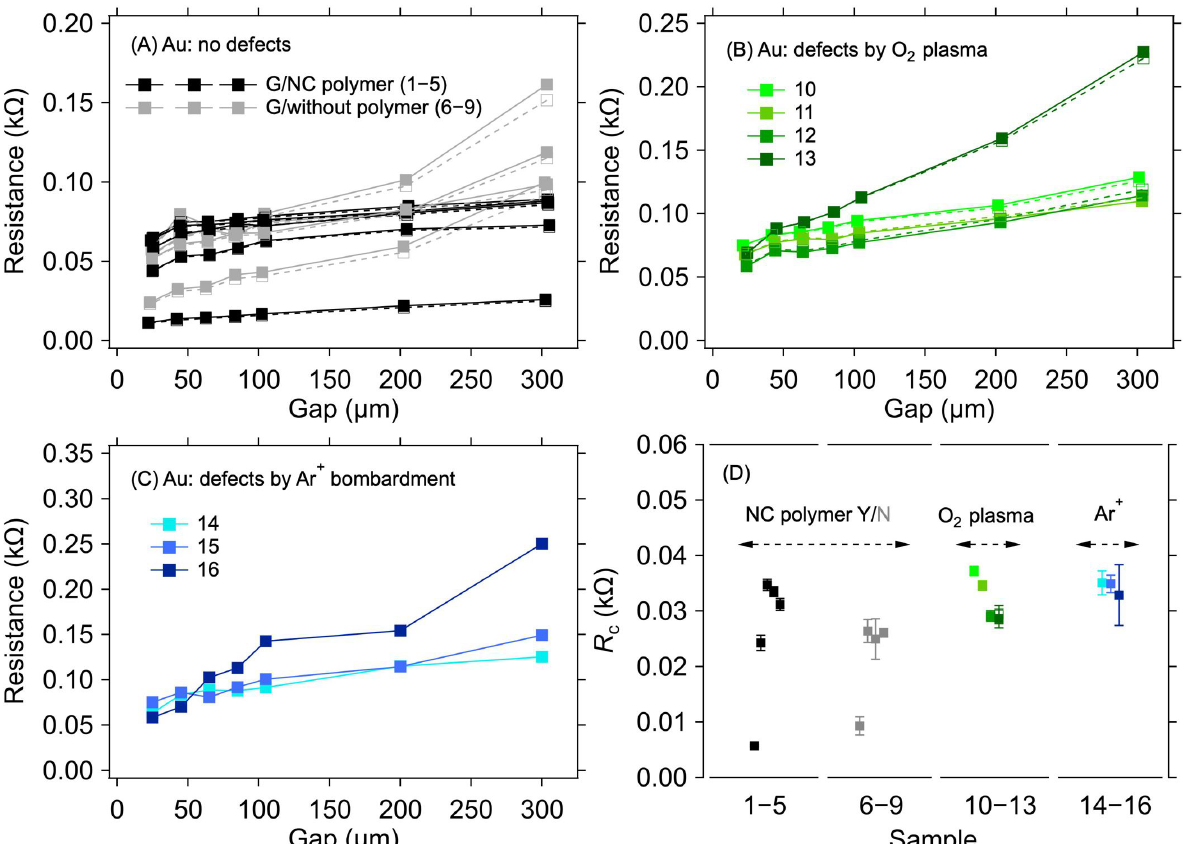
Figure 3. A 1L graphene–Au electrode contact resistance for different graphene manipulation meth- ods. Resistance as a function of electrode gap for ( A ) as-transferred graphene with the transferring nitrocellulose washed away (black) or left on the graphene (grey), ( B ) graphene with defects created by the O 2 plasma treatment, and ( C ) graphene with defects created by Ar + ion bombardment. The lines are guides for the eye only. ( D ) Contact resistance is determined from the measurements shown in panels ( A – C ) with corresponding colours. The error bars in ( D ) reflect one standard deviation of the linear fits for the R C determination. Solid and dashed lines and full and empty squares depict the first and second measurements (labelled as M1 and M2 in Table 2), respectively.